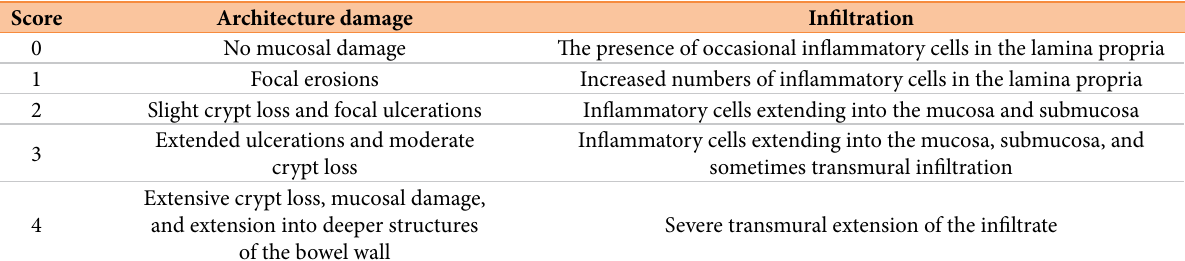
Table 2 - The criteria of histologic